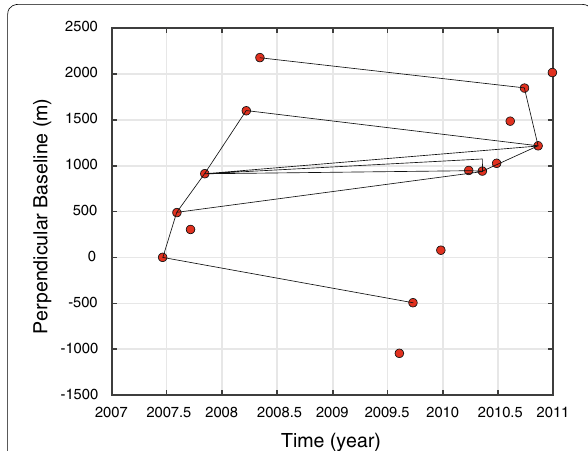
Fig. 2 SAR data acquisition dates (red circle) and interferometric pairs (black line) used for the time-series analysis. The details are provided in Table 1